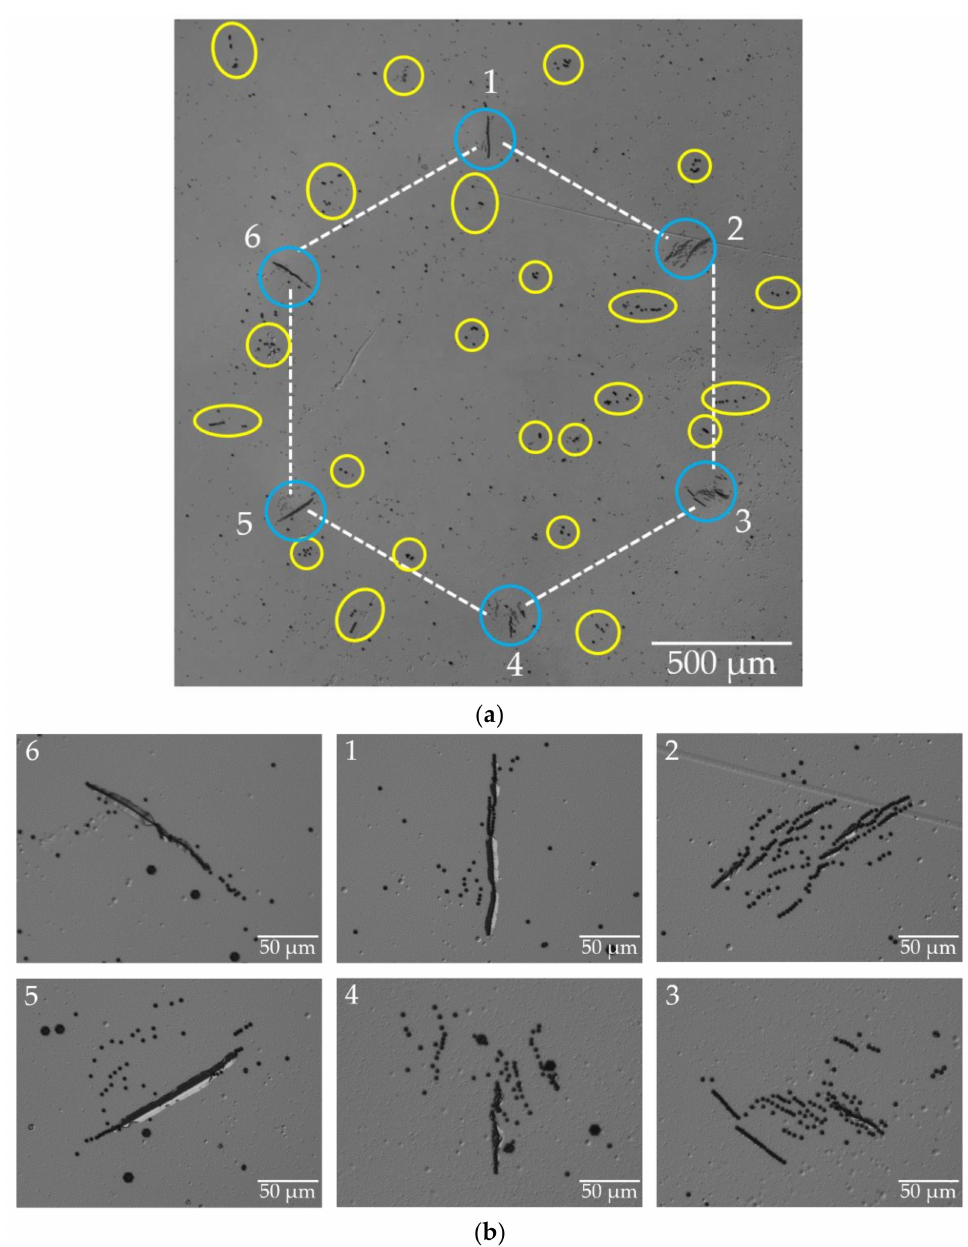
Figure 6. DIC optical images recorded after etching the HCD-A present in the Am-GaN substrate shown in Figure 2b: ( a ) overview image that allows identifying the bundles of TEDs that are concentrated in the corners of the honeycomb in very restricted locations (marked by blue circles); ( b ) enlarged images of the etch pits of the six dislocation bundles (DBs) located in the corners of the hexagon (a highly magnified image of the etched DB 5 is shown in Appendix B, Figure A4). The analysis of the pit size and morphology of the pits indicates that these are